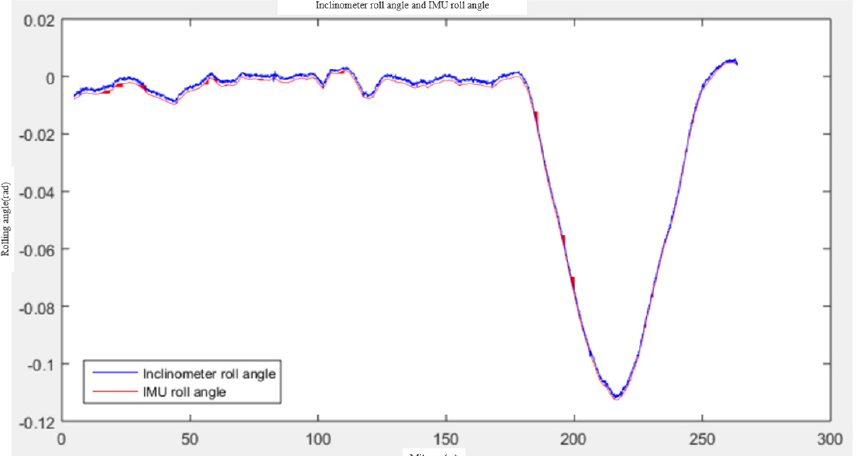
Figure 15. Inclinometer roll angle and IMU roll